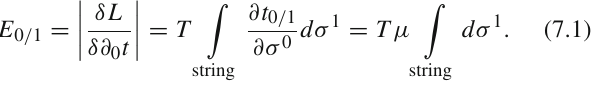
of ℘ ( a ) , or in other words, there is a minimum number of spikes required for the existence of the instability. This in strings always exposes this kind of instability (when they have translationally invariant counterparts). Figure 25